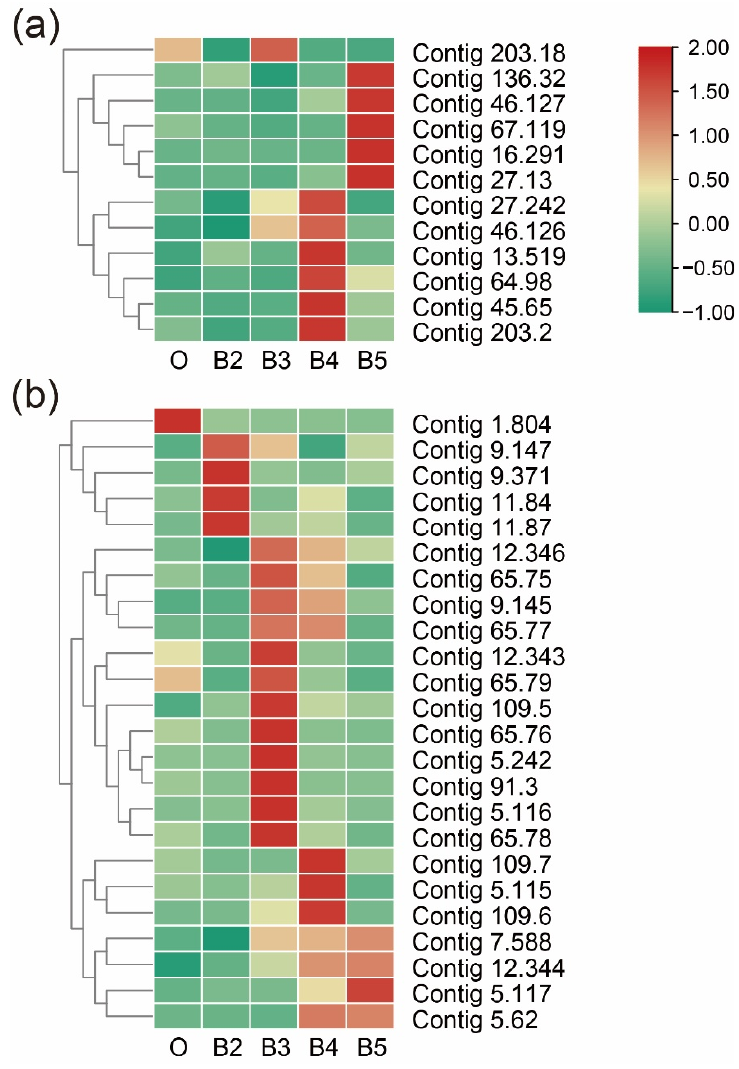
genes in this module. Pink circles represent genes encoding cuticular proteins ( CPs ). Lines represent the weight of connectivity between genes.